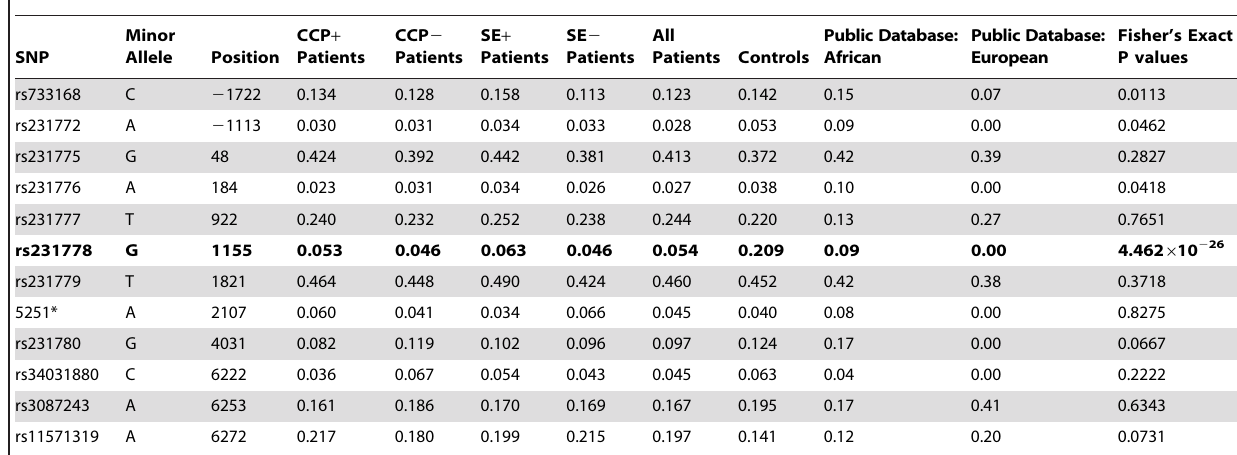
This table represents combined data from CLEAR I and CLEAR II. rs3087243 ( + 60C/T) has been associated with RA in Caucasians, and rs231775 ( + 49A/G) has been associated with other autoimmune conditions. Position is the physical location of each polymorphism relative to the start codon (position=0) in dbSNP build 129. CCP refers to anti-cyclic citrullinated antibody status. SE refers to presence of HLA-DRB1 shared epitope. Public databases include allele frequencies from HapMap or SeattleSNP. rs231776 was not in Hardy-Weinberg Equilibrium. *5251 is not currently listed in dbSNP as described in the